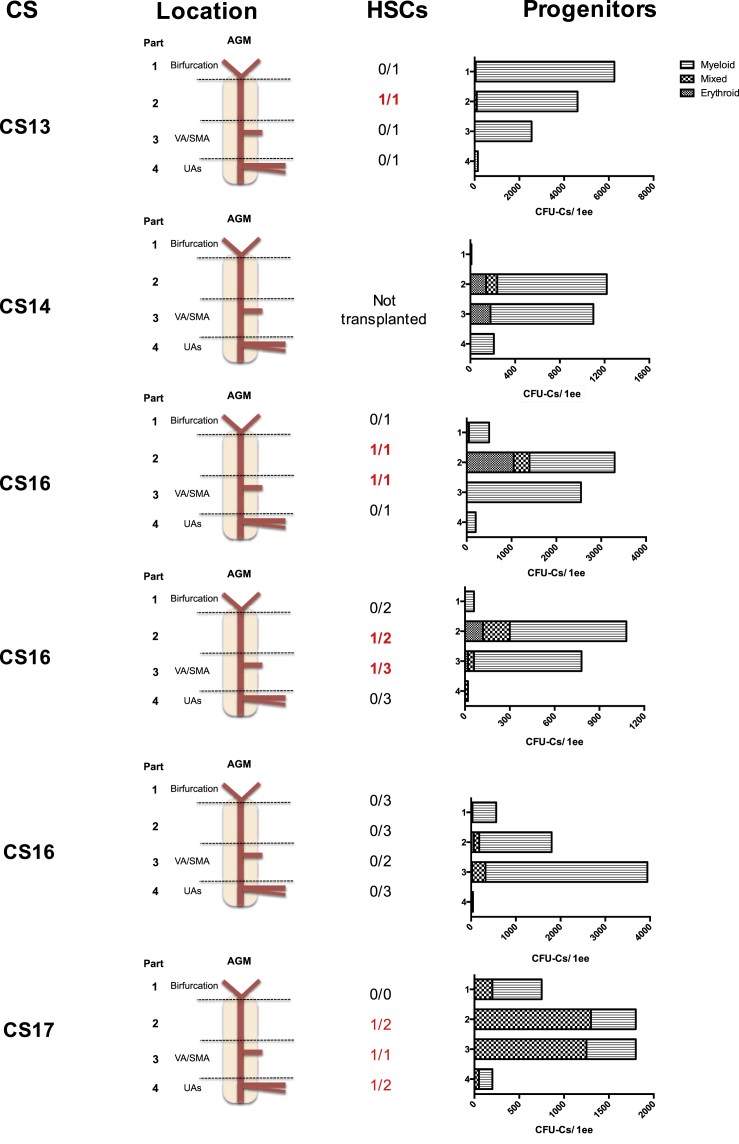
Relative Spatial Distribution of CFU-Cs and HSCs from the Human AGM after CultureMapping experiments demonstrating the location of HSCs and CFU-Cs in each of four parts of the AGM (see Figure S2) after 7 days of explant culture with addition of SCF 100 ng/mL are shown. Numbers and types of CFU-Cs are shown along with the Carnegie stage (CS) of each independent experiment. The corresponding number of mice with long-term multilineage engraftment relative to the number of mice injected is shown for each part of the AGM. The repopulated mice correspond to those shown in Tables 1, 2, and 3. ee, embryo equivalent; UAs, umbilical arteries; VA/SMA, vitelline artery/superior mesenteric artery. See also Figure S2.